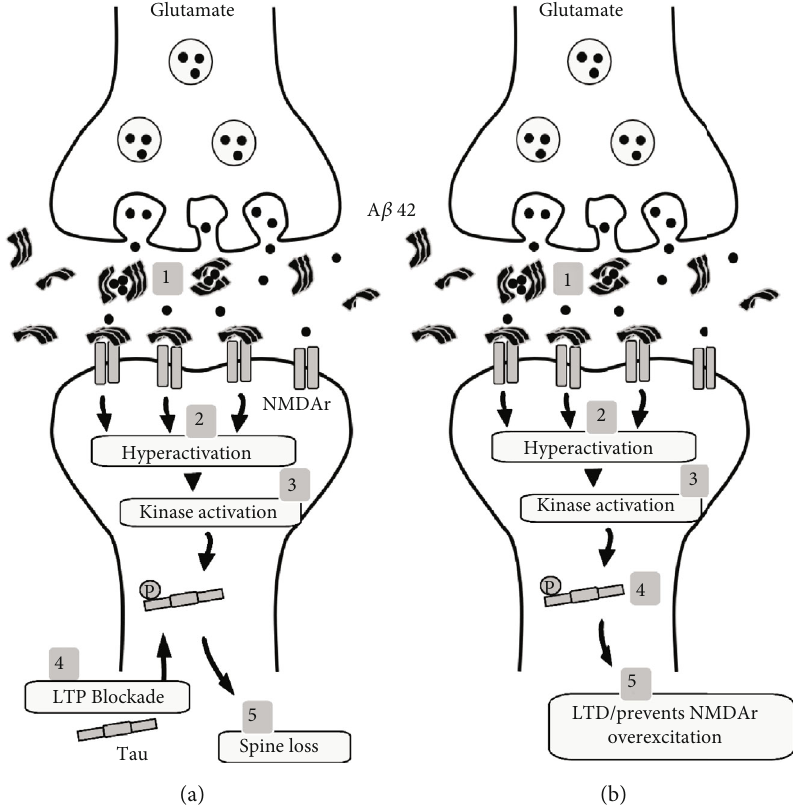
Figure 3: pTau protein at MD (microtubule domain) prevents NMDAr overexcitation, which accounts for protection rather than damage. (a) A β 42 oligomers repeatedly a ff ect neurons by blocking glutamate reuptake (1), which leads to hyperactivation (2), kinase activation (3), Tau hyperphosphorylation, and Tau translocation from the axon to the dendritic spines (4) causing LTP blockade and progressive spine loss (5). (b) Alternatively, A β 42 oligomers block glutamate reuptake (1), which leads to hyperactivation (2), kinase activation (3), and Tau phosphorylation at MD sites (4), which alternatively promote LTD, preventing further NMDAr-mediated overexcitation and producing neuroprotection